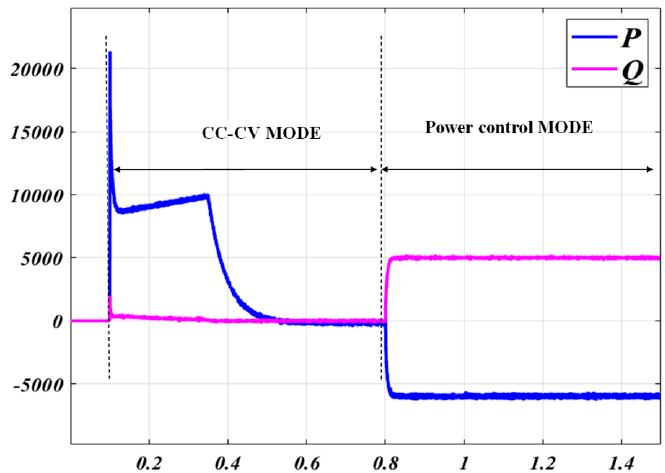
Figure 23. Simulation results of active/reactive power.